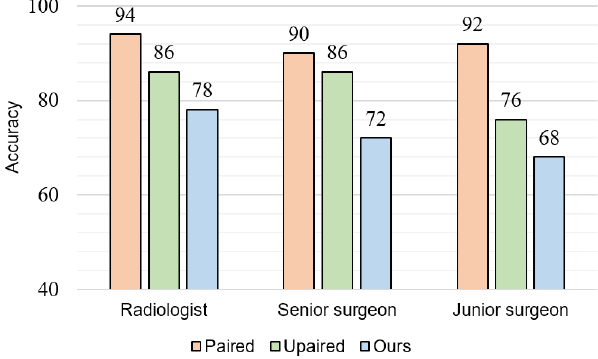
Figure 8. Blind test of “reference vs. estimated” MR images corresponding to the CT images.